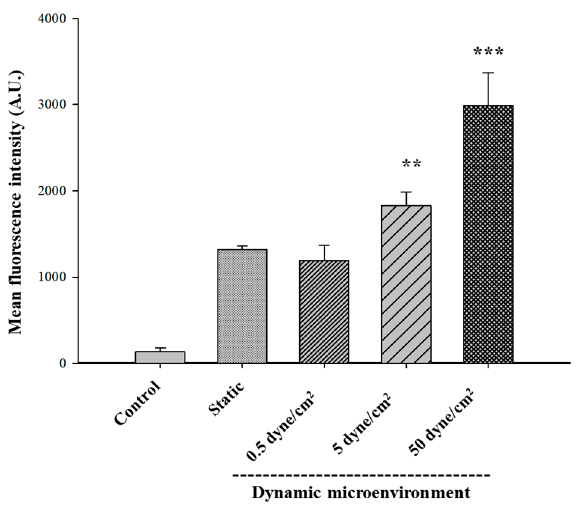
Figure 5. Cellular uptake of C-GONs by A549 cancer cells under a static or biomimetic dynamic microenvironment for 1 h (mean ± SD; n = 3, ** p < 0.01; *** p < 0.001).